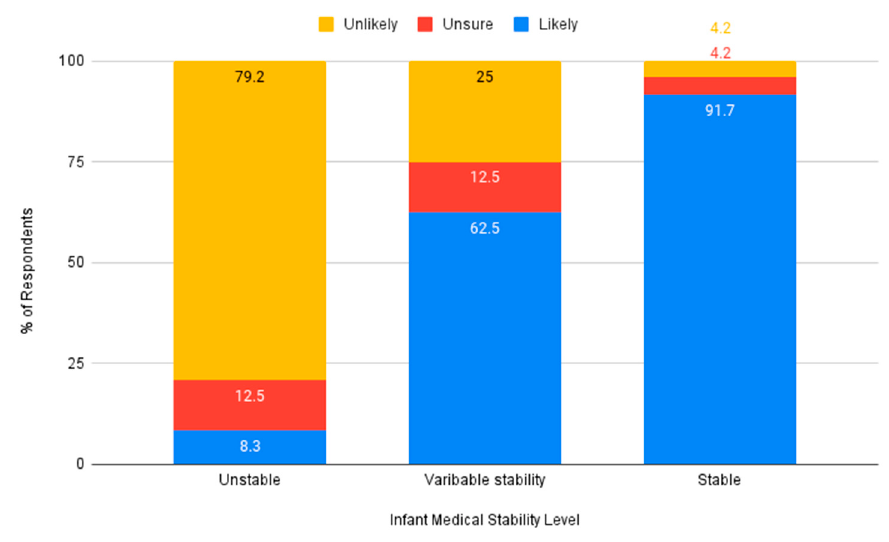
Figure 5. Likeliness to advocate for an auditory intervention based on medical stability.